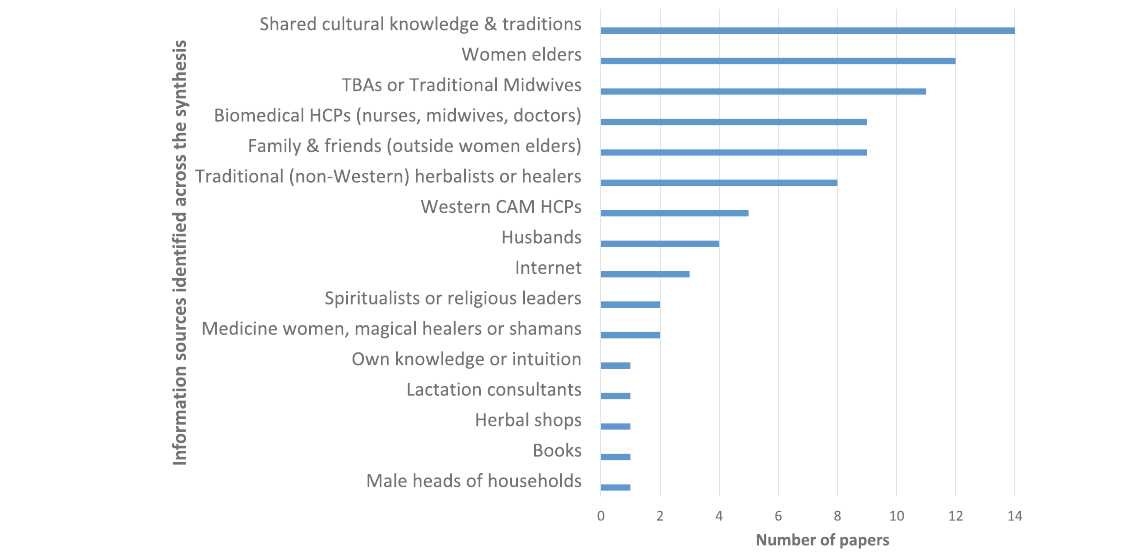
Fig. 3 Information sources accessed by women regarding using CMPs in pregnancy and lactation across the